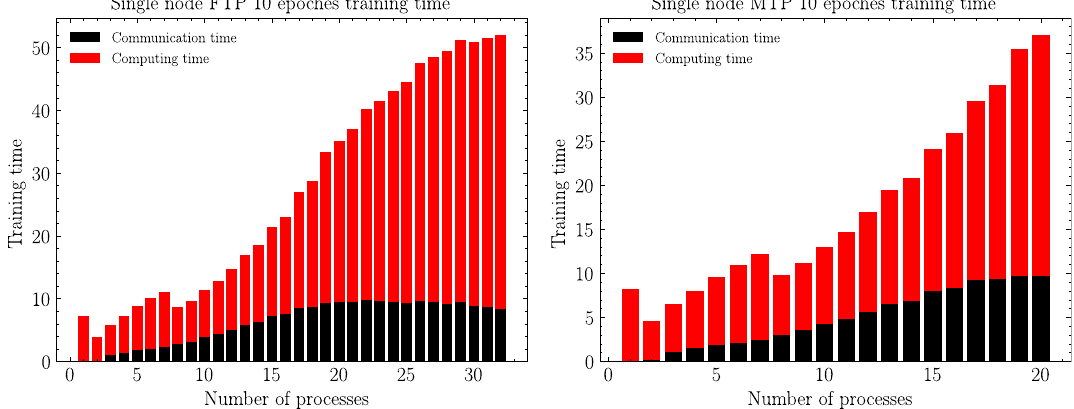
Figure 9. MT2000+ and FT2000+ single node computing and communication time.